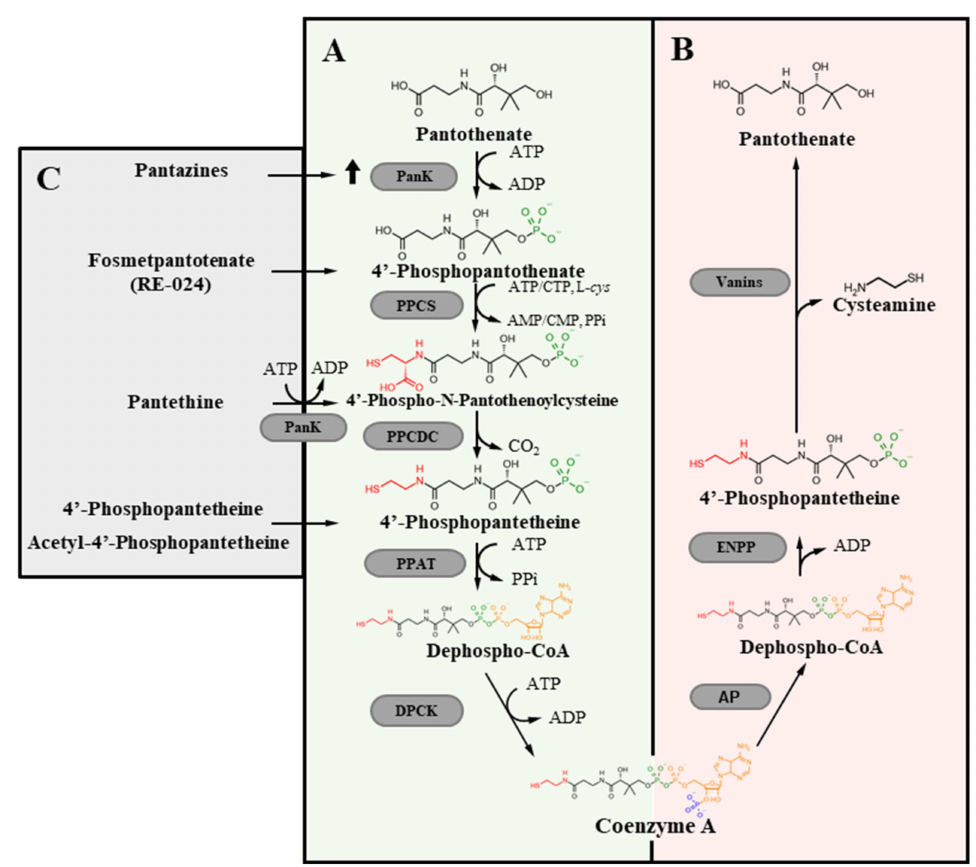
Figure 1. CoA homeostasis. Schematic description of the intracellular de novo CoA biosynthetic ( A ) and degradation pathways ( B ). Molecules shown to be able to correct defects due to a blockage in the first step of CoA biosynthesis ( C ). PANK, pantothenate kinase; Abbreviations: PPCS, phosphopantothenoylcysteine synthetase; PPCDC, phosphopantothenoylcys- teine decarboxylase; PPAT, phosphopantetheine adenyltransferase; DPCK, dephospho-CoA kinase; ENPP, ectonucleotide